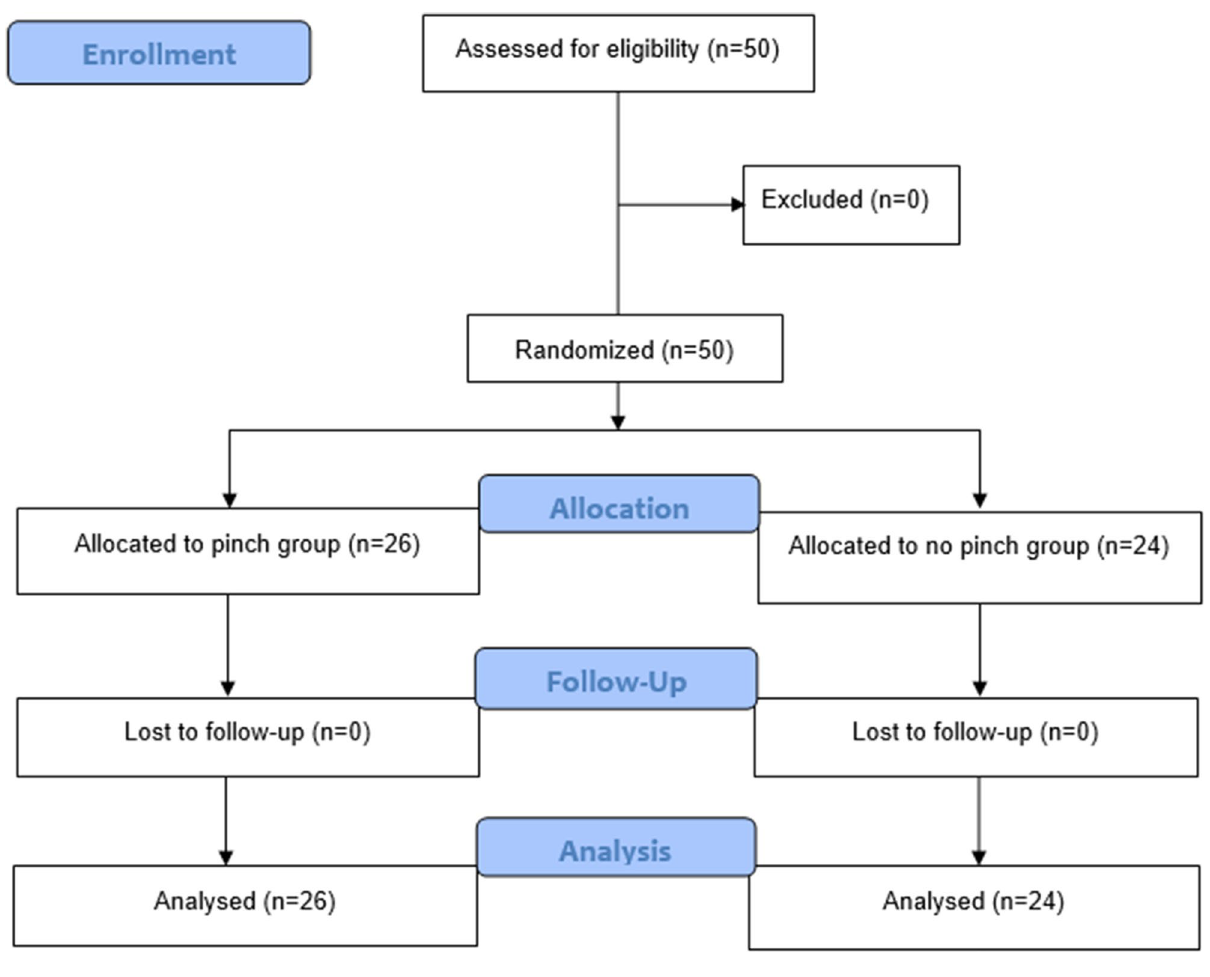
Figure 1. Participant flow diagram.